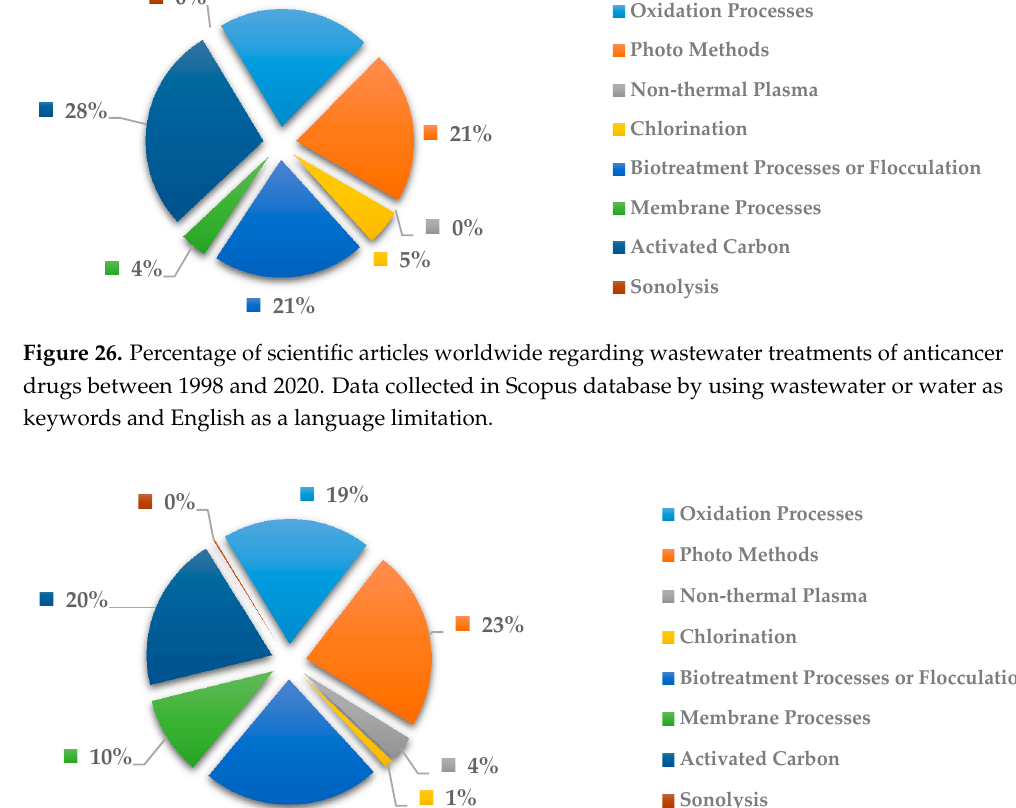
Figure 28. Percentage of scientific articles worldwide regarding wastewater treatments of psychiatric-neurological drugs between 1998 and 2020. Data collected in Scopus database by using wastewater or water as keywords and English as a language limitation. Figure 29. Percentage of scientific articles worldwide regarding wastewater treatments of metabolic disorder drugs be- tween 1998 and 2020. Data collected in Scopus database by using wastewater or water as keywords and English as a language limitation.